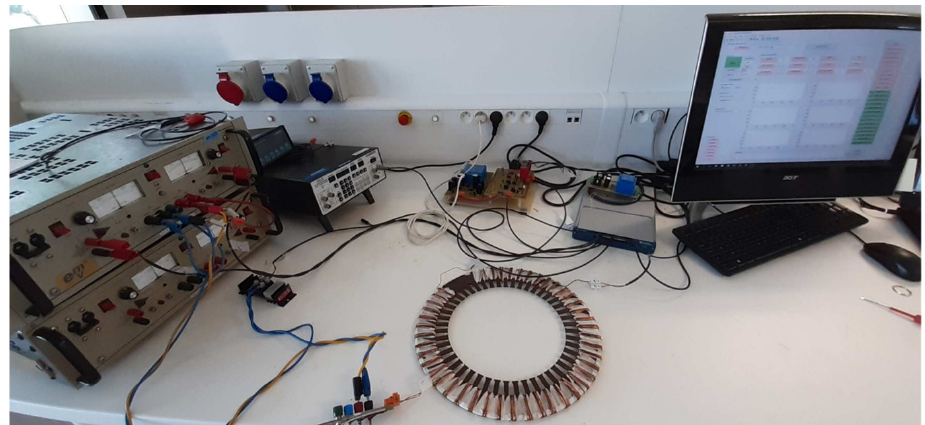
Figure 8. Setup used for obtaining loss measurements: amplifier (left), welded stator core (center) and data acquisition system (right).